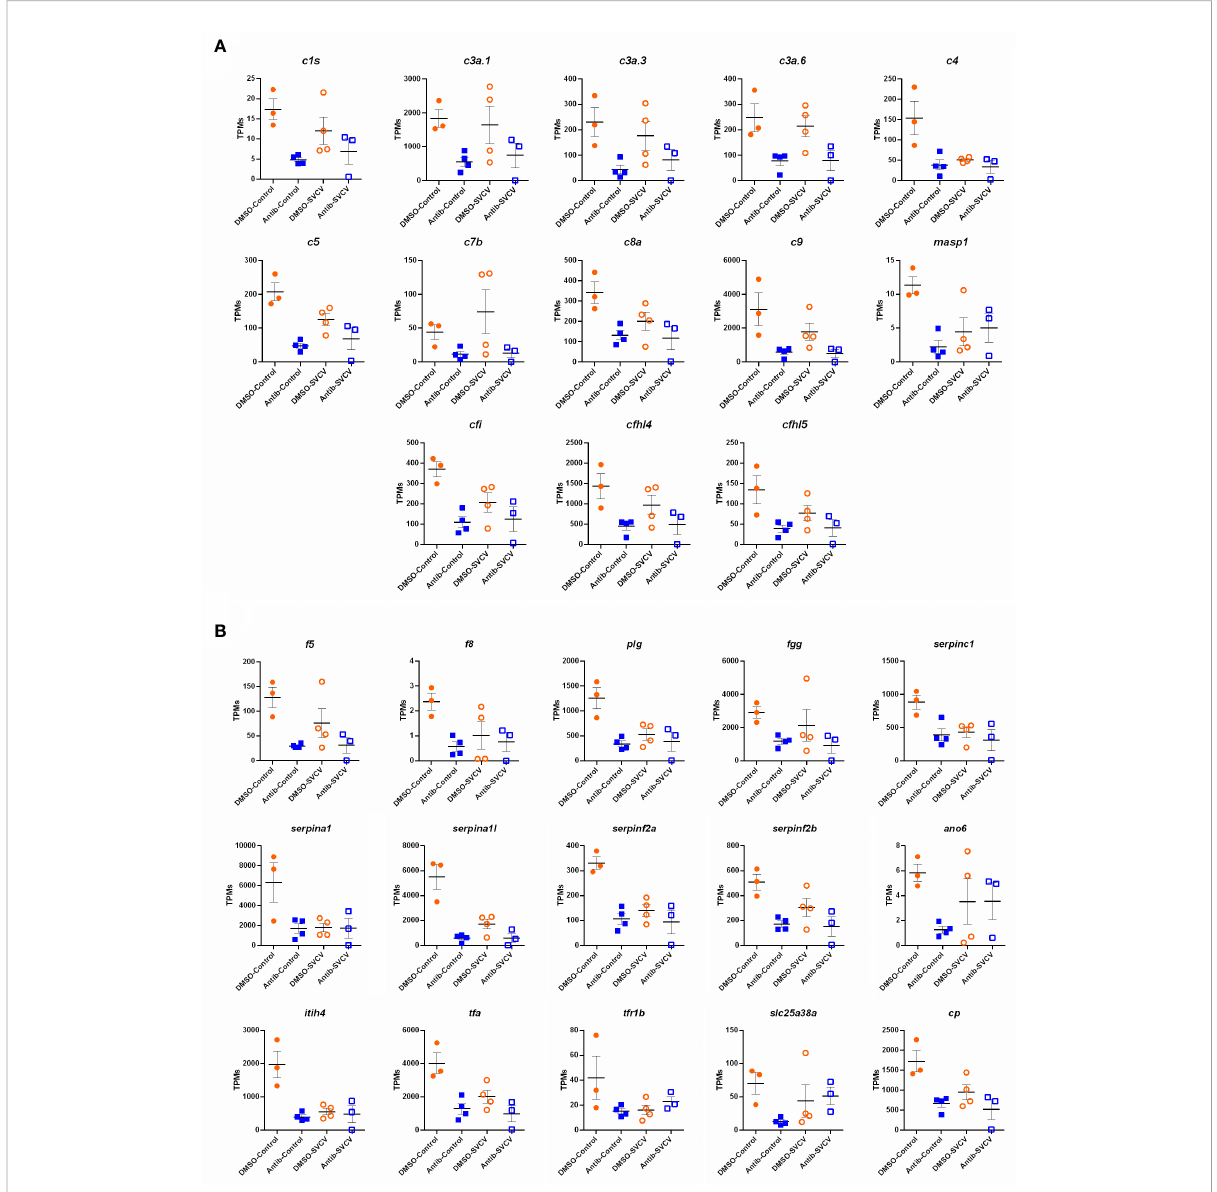
FIGURE 8 Representation of the TPM values of the (A) complement and (B) coagulation genes signi fi cantly modulated in the intestines of fi sh exposed to SMX-CLA compared to those exposed to DMSO